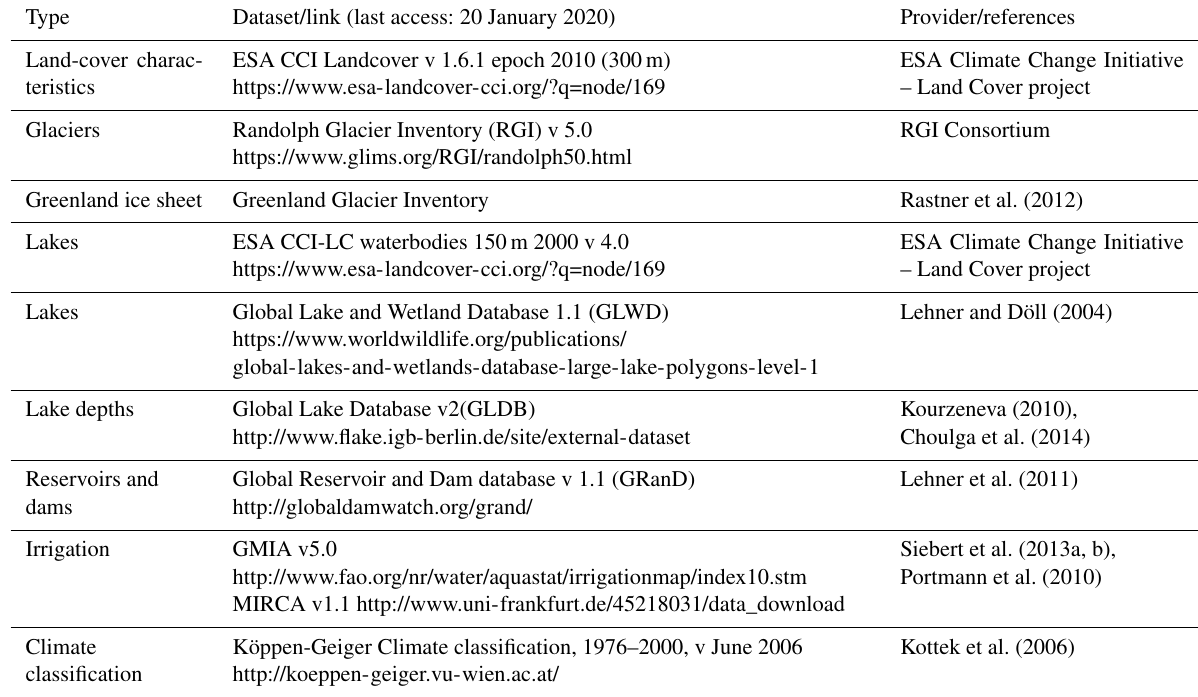
Table 2. Databases used to assign land cover, waterbodies, and climate to catchments in WWH version 1.3.